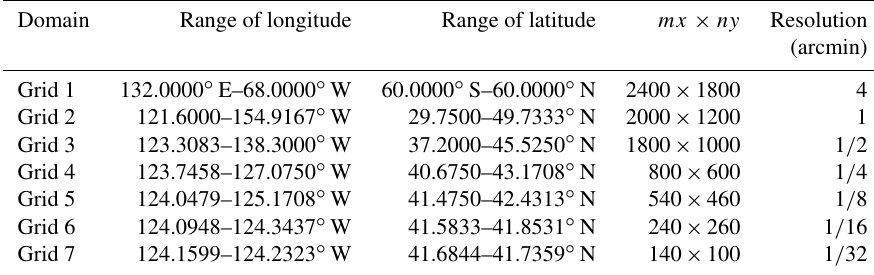
Table 2. Grid parameters for the 2011 Tohoku-Oki tsunami